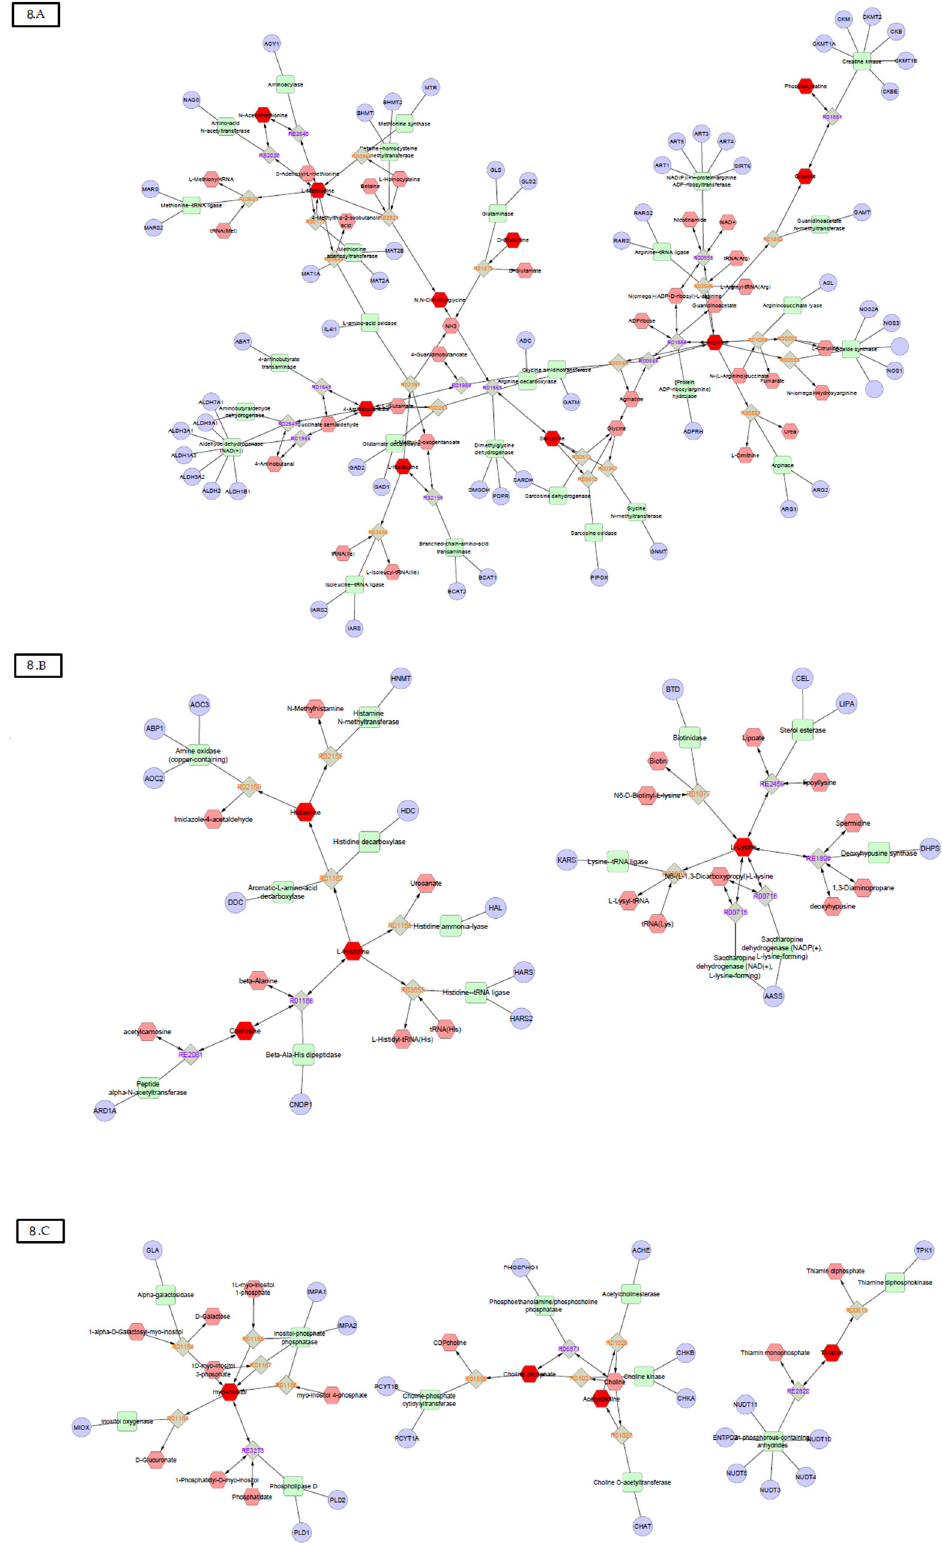
Figure 8. Pathways that are related to amino acid metabolism.